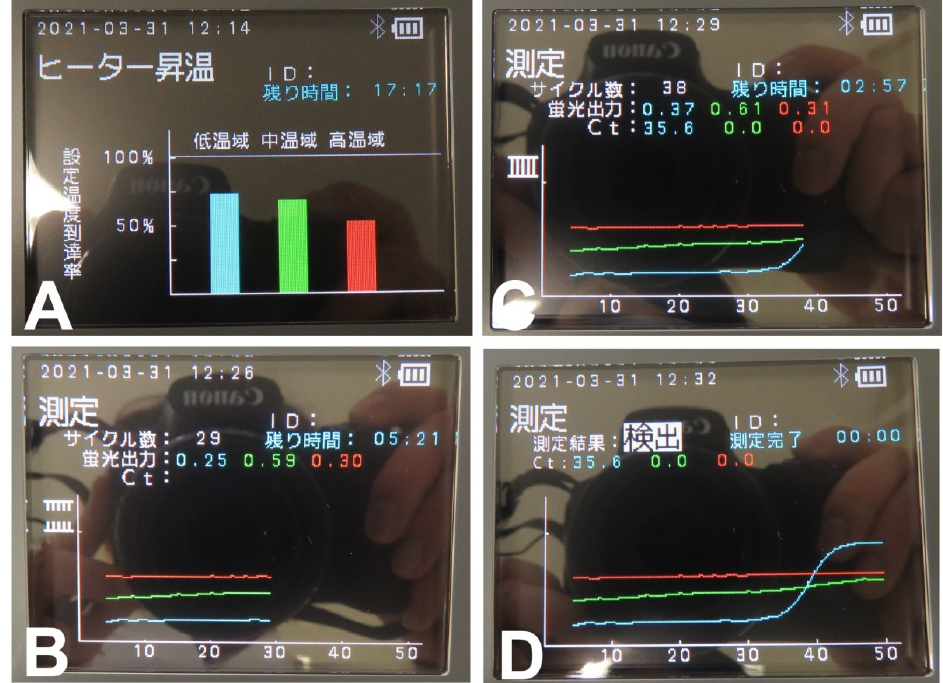
Figure 4. Screen display during qPCR with PCR1100: ( A ) The heat block heating up. ( B ) Amplification reaction. Three graphs are displayed as it progresses. Blue, RNase P; Green, CDC N1; Red, CDC N2. ( C ) The blue graph shows an increase (i.e., presence of RNA). The Ct value when the graph rises is displayed (here, it is 35.6). ( D ) The reaction continues up to 50 cycles. At the end of 50 cycles, the final measurement result and each Ct value are displayed.